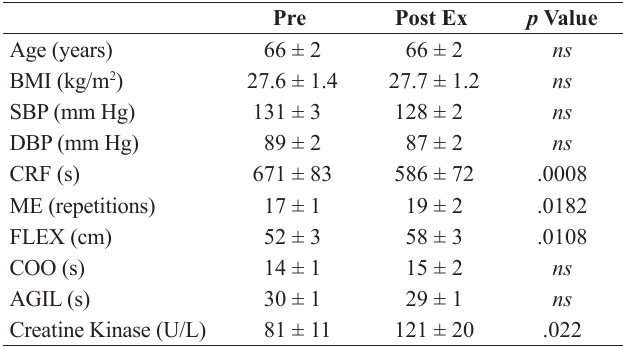
Table 1. Characteristics of the participants at Baseline (Pre) and after 24 weeks (Post Ex) of Moderate-intensity